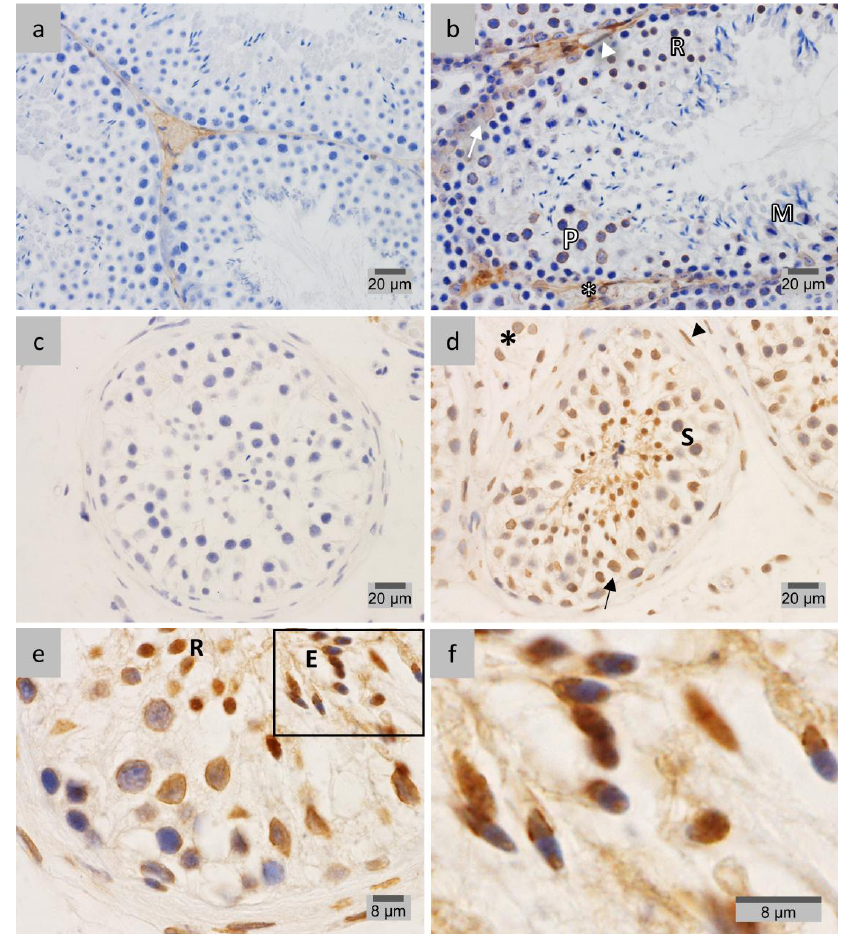
Figure 6. Immunohistochemical localization of lamin B1 in mouse testis sections fixed in diluted Bouin’s solution ( a , b ) and human testis sections fixed in 4% PFA ( c – f ). Positive immunostaining appears in brown color and nucleus counterstaining with hematoxylin. (a,c) Negative controls showed lamin B1 staining in the interstitial tissue. (b) In mouse testis, lamin B1 is present in the NE of peritubular (arrowhead), Leydig (asterisk) and Sertoli (arrow) cells, spermatogonia, pachytene spermatocytes (P) and round spermatids (R). Lamin B1 is also distributed in the cytoplasm of meiotic cells (M). (d) In human seminiferous tubules, lamin B1 is clearly detected in the NE of peritubular (arrowhead), Leydig (asterisk) and Sertoli (arrow) cells, in addition to spermatocytes (S). (e) In spermiogenic cells, lamin B1 is found in the nucleus of round spermatids (R). Additionally, lamin B1 is located in the centriolar pole of elongating and elongated mature spermatids (E). (f) ROI from Figure 6e. PFA: paraformaldehyde; NE: nuclear envelope; ROI: region of interest.